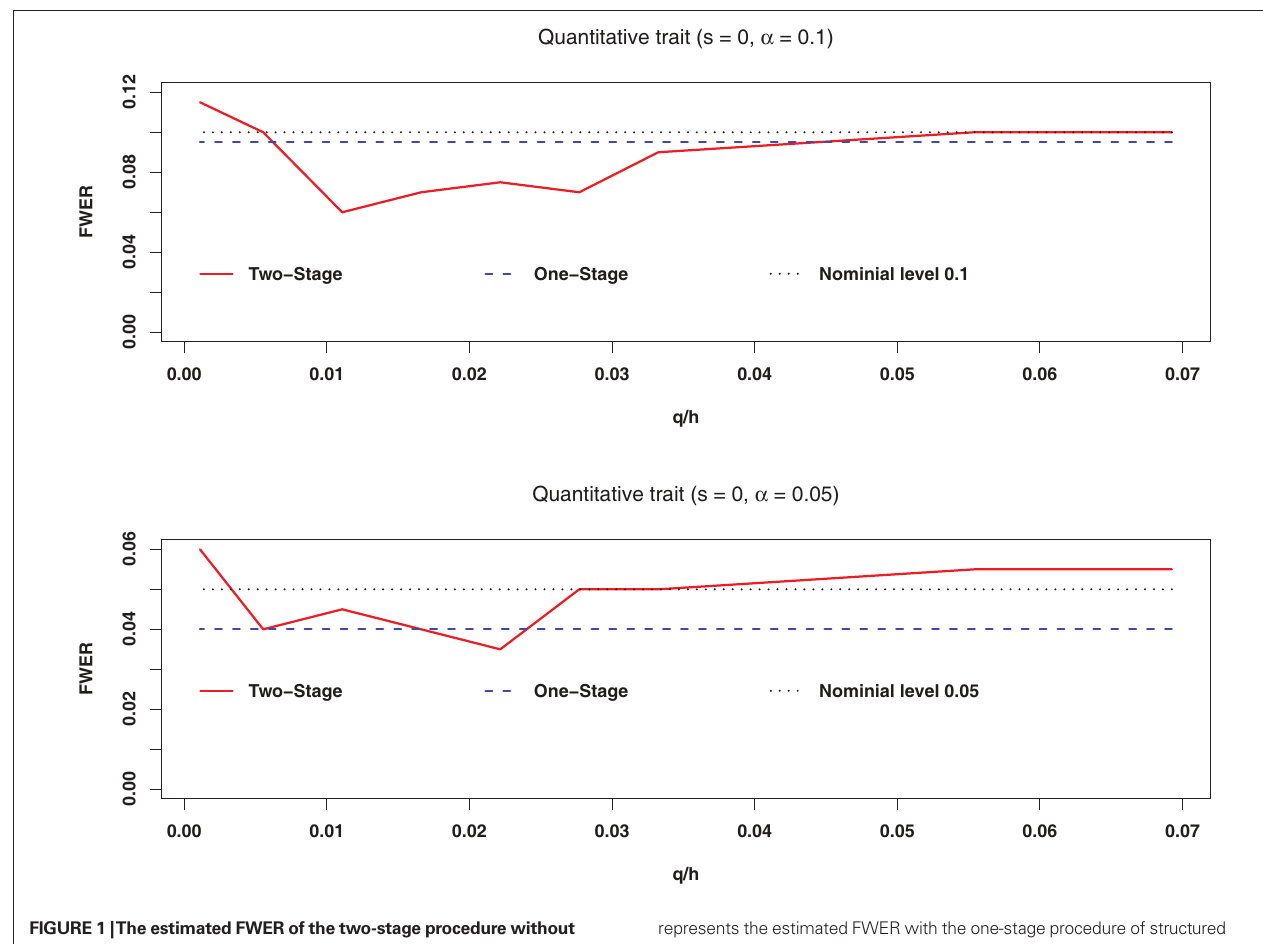
FiGure 1 | The estimated FWer of the two-stage procedure without confounding association by admixture at significance levels of 0.1 and 0.05 (200 replicates). The red solid line represents the estimated FWER with the two-stage procedure of structured association tests; the blue dashed line